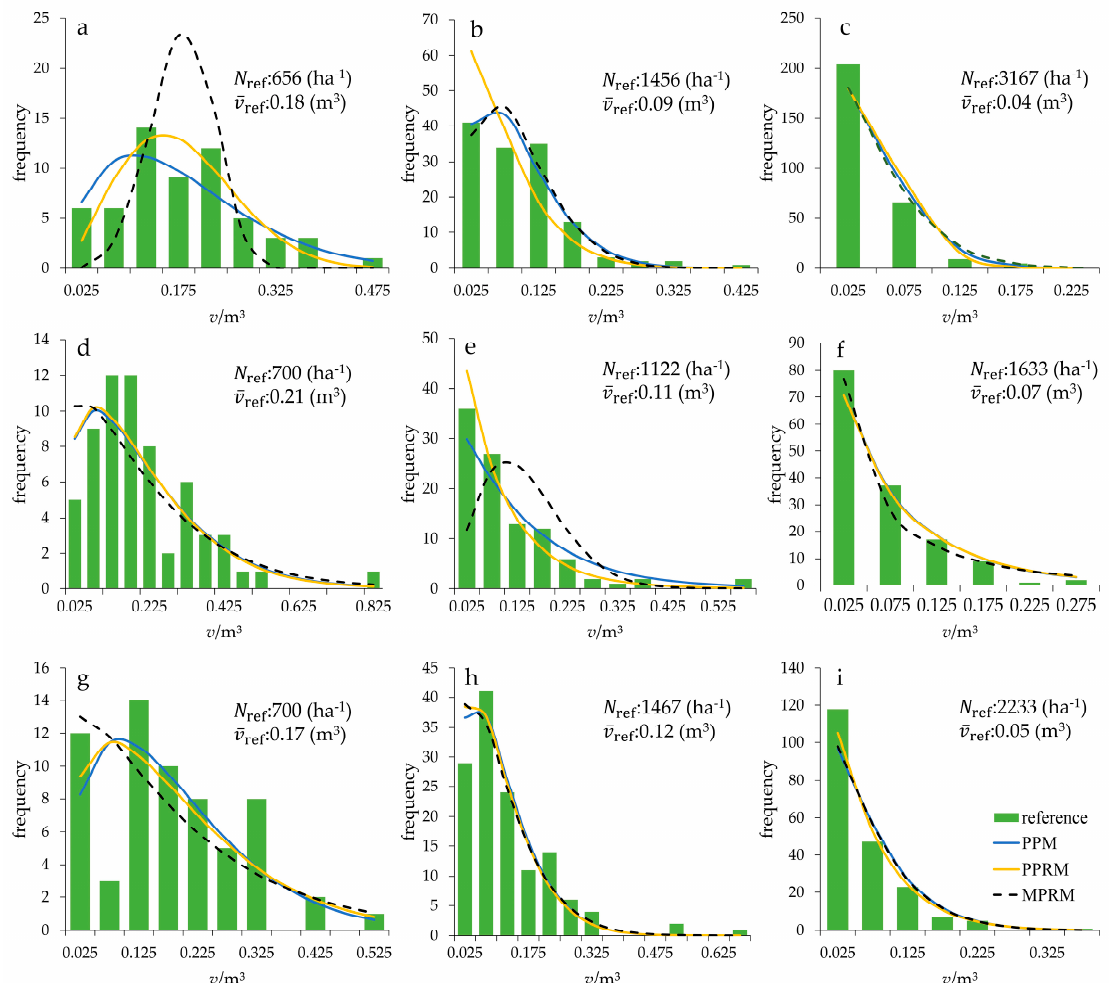
Figure 4. The reference tree volume distribution (green bars) fitted with the Weibull distribution based on the Weibull parameters derived from the PPM, PPRM, and MPRM (using LiDAR-predicted stem density N LiDAR as scaling variables) for nine sample plots of coniferous forests ( a – c ), broadleaved forests ( d – f ), and mixed forests ( g – i ) in low (left panel), medium (median panel) and high (right panel) stem densities. PPM: parameter prediction method; PPRM: percentile-based parameter recovery method; MPRM: moment-based parameter recovery method; N ref : field reference stem density; v ref : field mean tree volume.